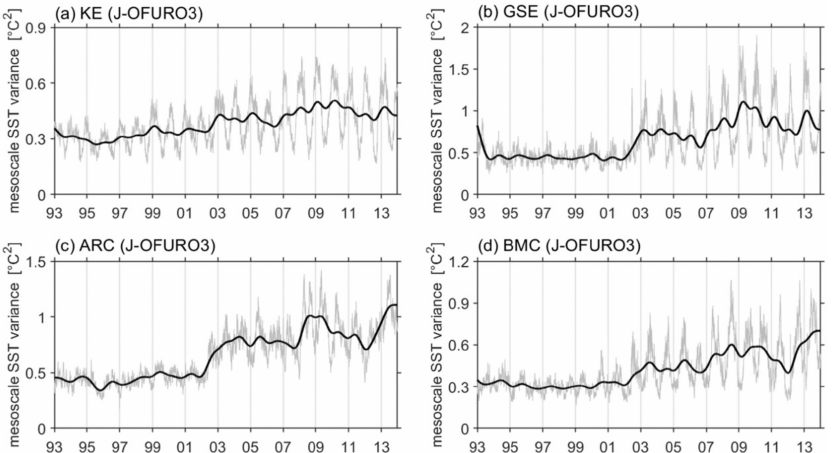
Figure 13. Time series of the mesoscale SST variance based on the CFSR data in the regions of ( a ) KE, ( b ) GSE, ( c ) ARC, and ( d ) BMC. The thin and thick lines denote the daily and 1.5-year low-pass filtered time series,